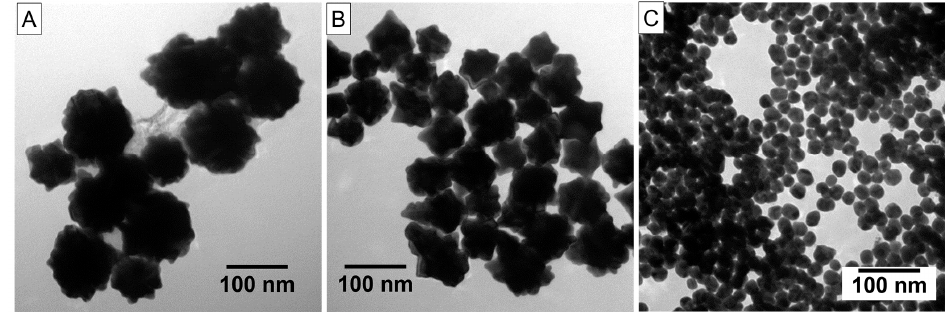
Figure 1. TEM images of AuNPs after concentration: ( A ) large CAuNPs, ( B ) small CAuNPs, and ( C ) spherical AuNPs.